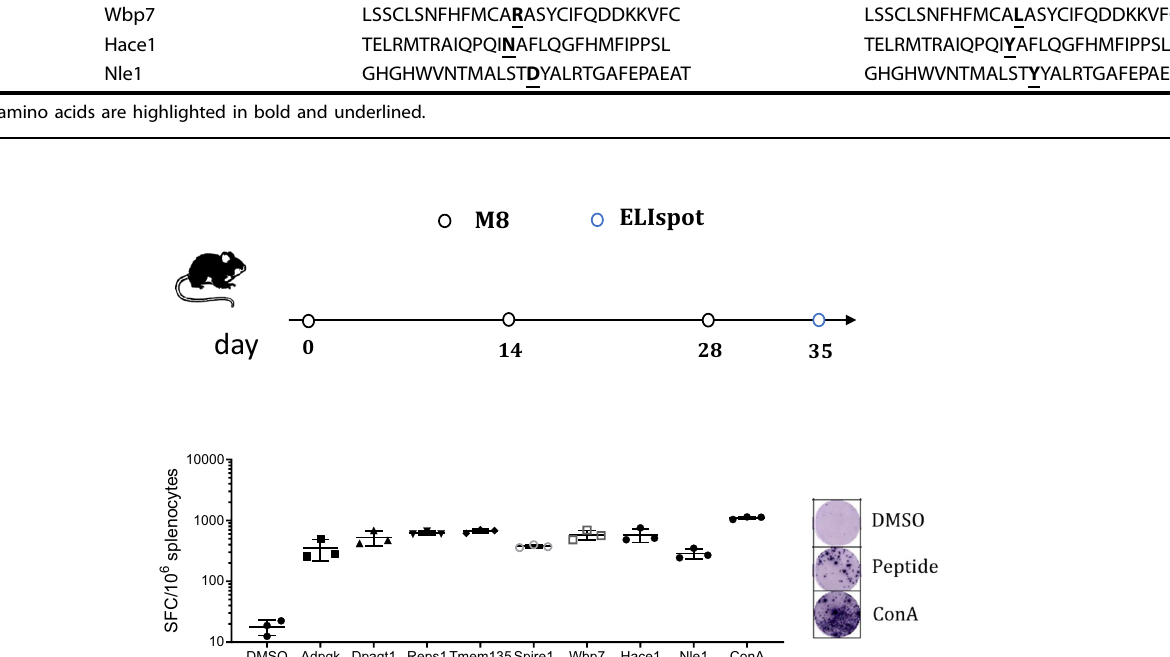
Mutated amino acids are highlighted in bold and underlined.